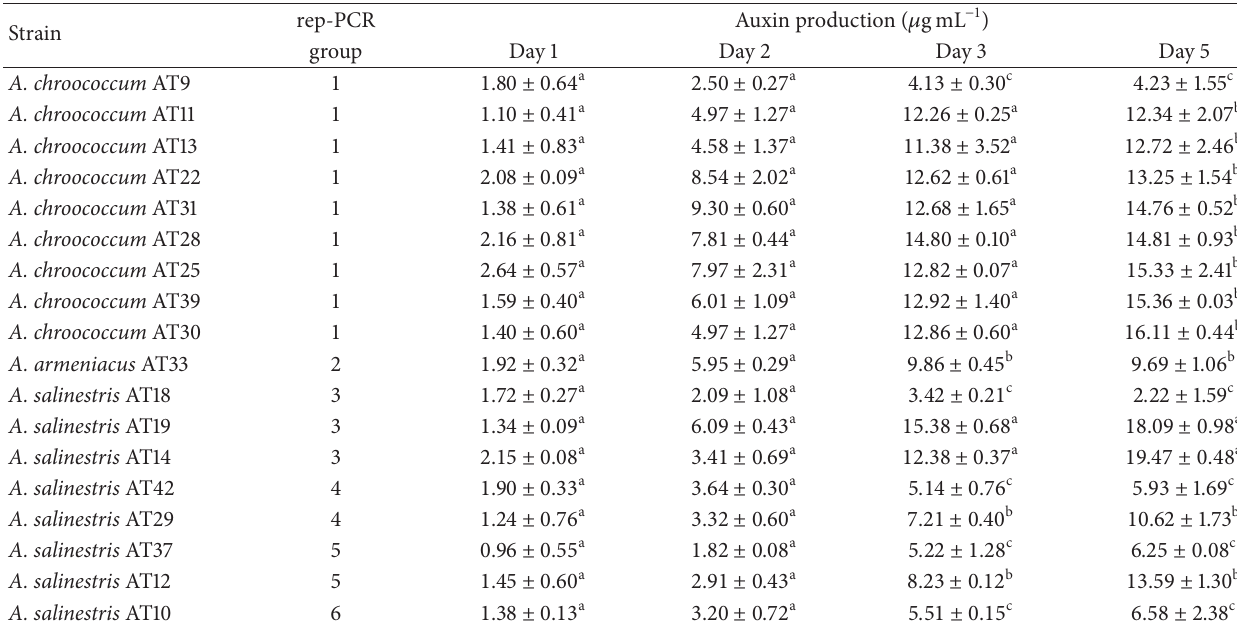
Table 2: Auxin production capacity of representative Azotobacter strains as determined by a colorimetric assay using the Salkowski reagent and results of rep-PCR clustering.